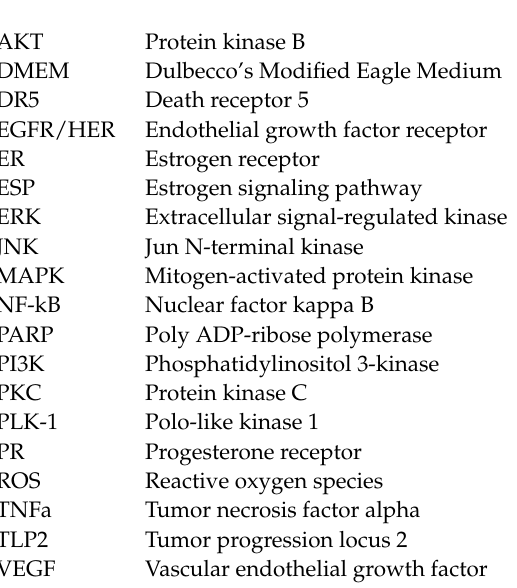
of (a) Luteolin and (b) as-prepared L-ZnONPs, Figure S4: UV-Visible spectrum of the as-obtained L-ZnONPs, Figure S5: The after docking 3D structures of L-ZnONPs with (A) 1Q4O, (B) 2FK9, (C) 2LAV, (D) 3PP0, (E) 4RIW and (F)